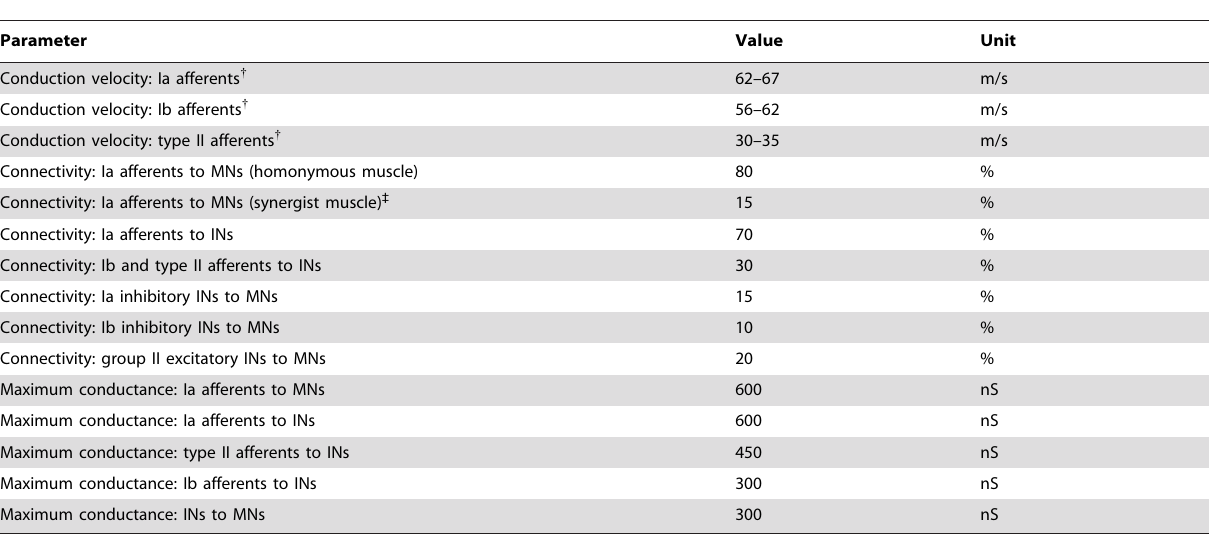
Table 6. Sensory feedback parameters adopted in the